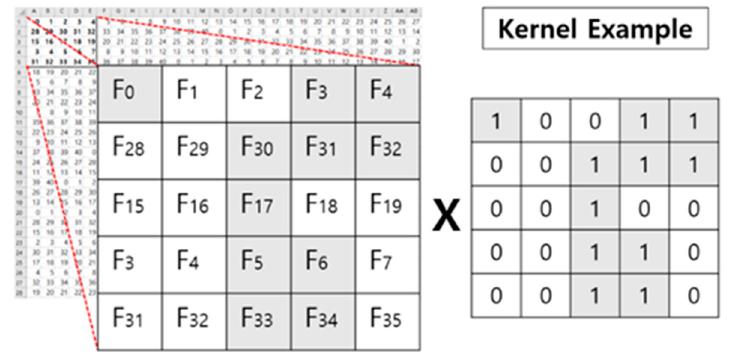
Figure 1. Proposed preprocessing methodology.